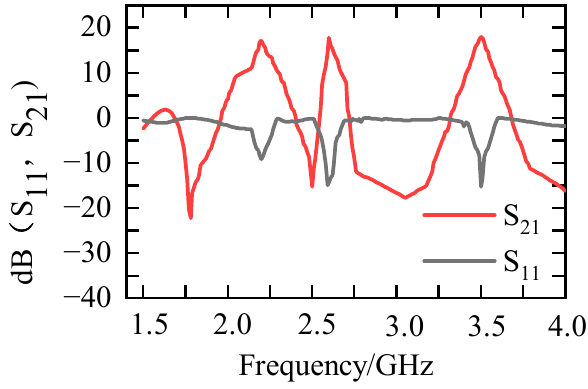
Figure 7. Test results of s parameters. The output power, power-added efficiency, and gain results at the three frequency bands of 2.2/2.6/3.5 GHz are shown in Figure 8. At 2.2 GHz, the input power increases from 10 dBm to 30 dBm, and the output power and power-added efficiency increase with the input power. The peak output power reaches more than 40 dBm, the power-added efficiency reaches between 50% and 63%, and the gain is about 11–13 dBm. At 2.6 GHz, the input power increases from 11 dBm to 30 dBm, and the output power and power-added efficiency increase with the input power. The peak output power reaches more than 40 dBm, and the power-added efficiency reaches between 65% and 70%. The gain is about 12 to 13 dBm. At 3.5 GHz, the input power increases from 10 dBm to 30 dBm, and the